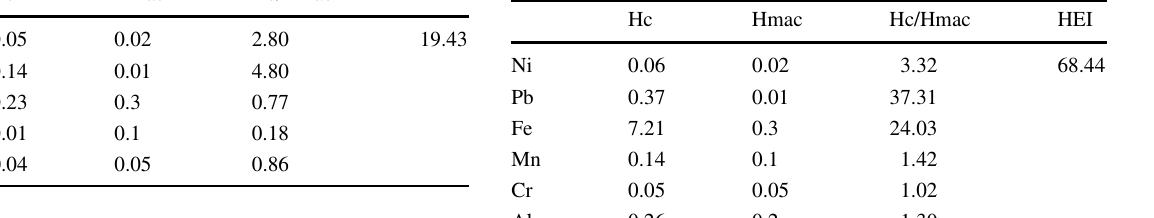
Table 7 Heavy metal evaluation index for groundwater at site 5